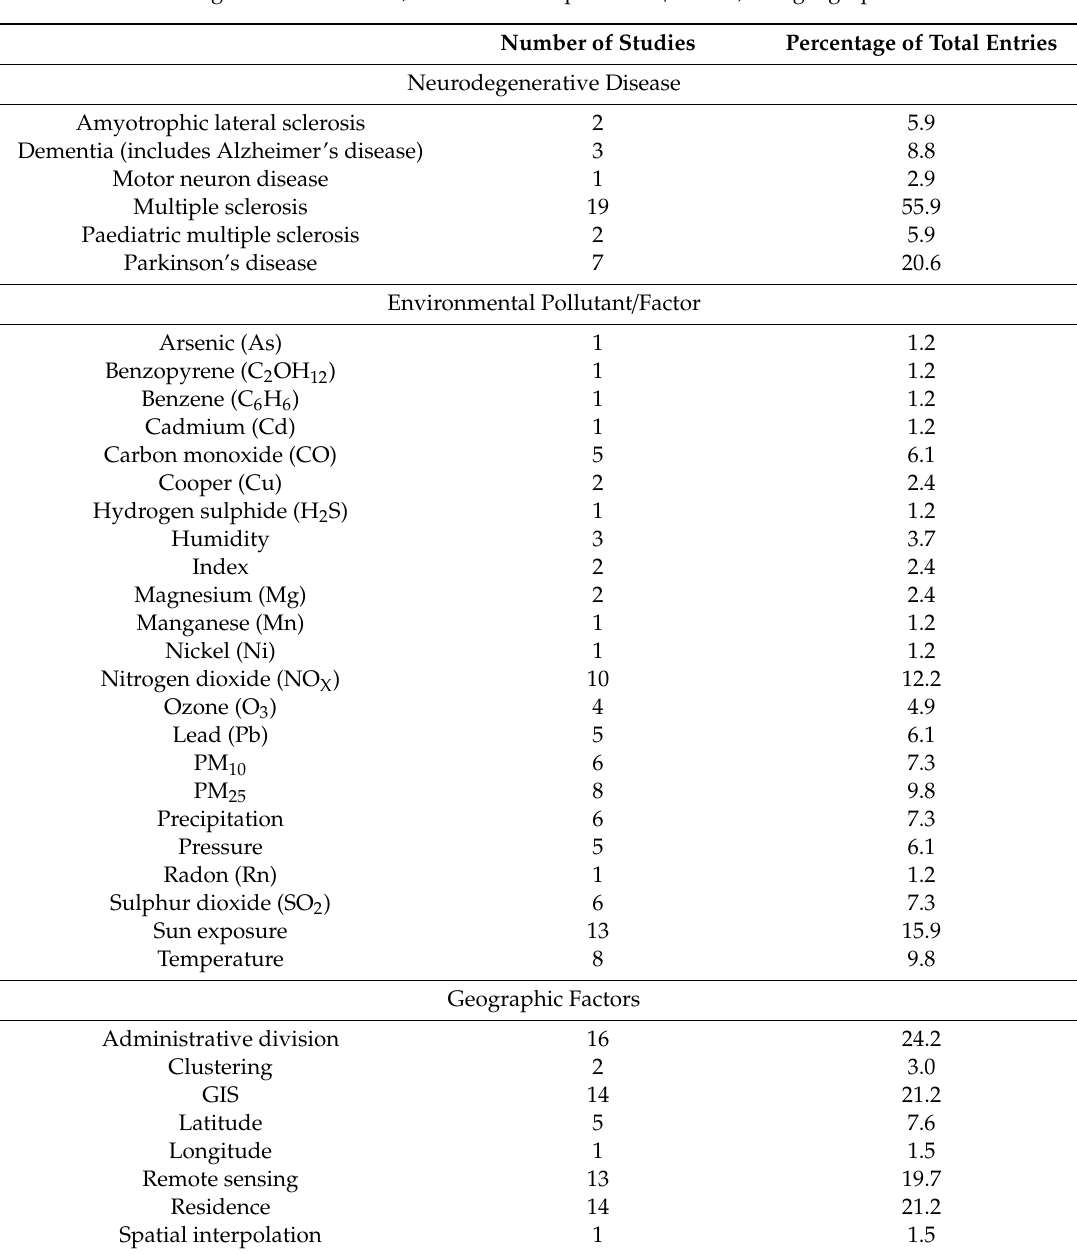
Table 1. The number of studies addressing each subtopic of the domains, retrieved from the included studies: neurodegenerative diseases, environmental pollutants / factors, and geographic